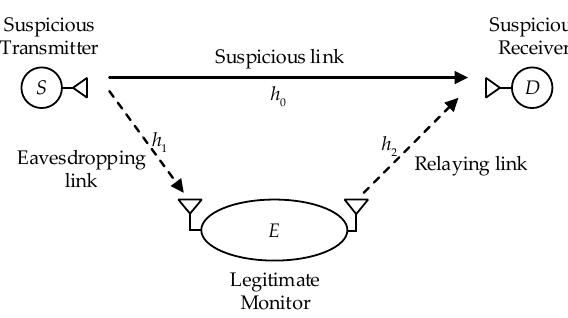
Figure 1. System model of the considered legitimate surveillance system.